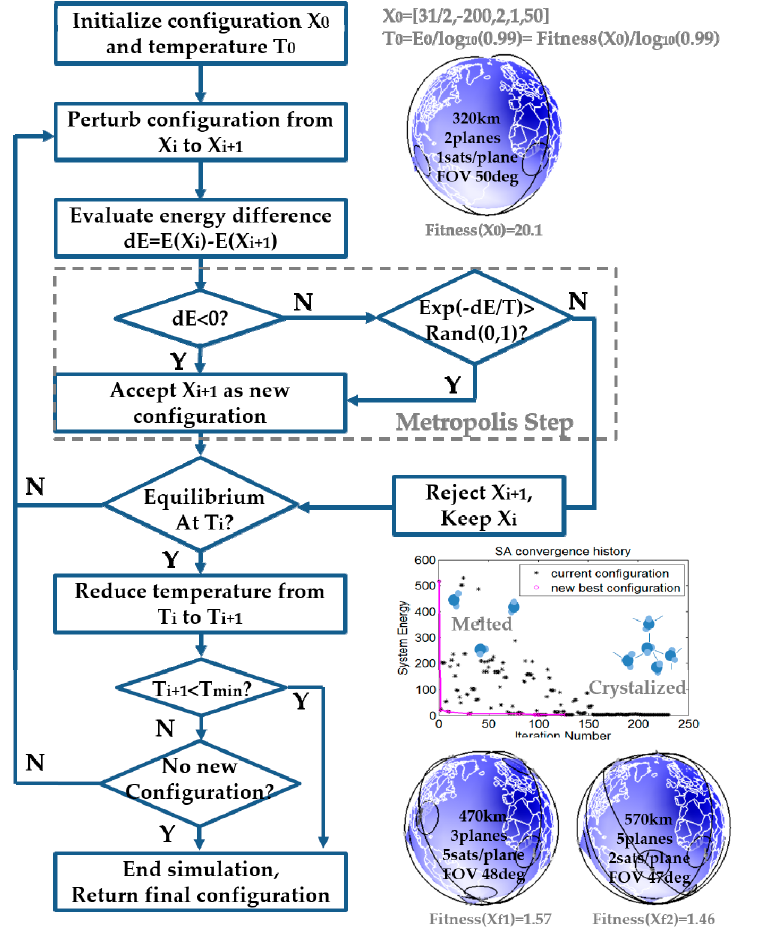
Figure 10. Simulated Annealing (SA) algorithm. Table 10. Range and initial value of design variables in